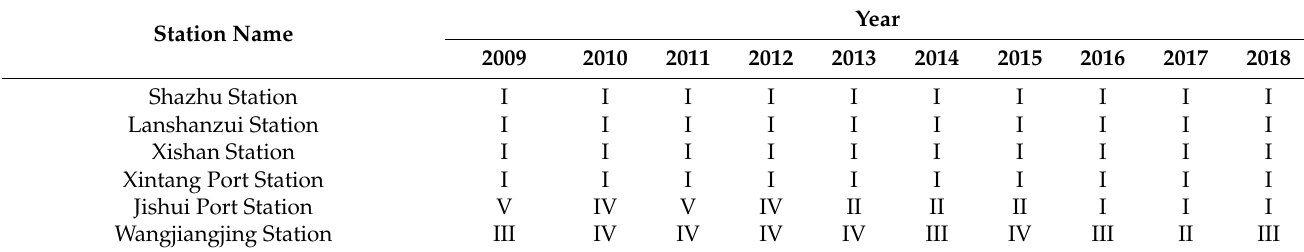
Table 3. Water quality evaluation results based on the fuzzy integrated evaluation